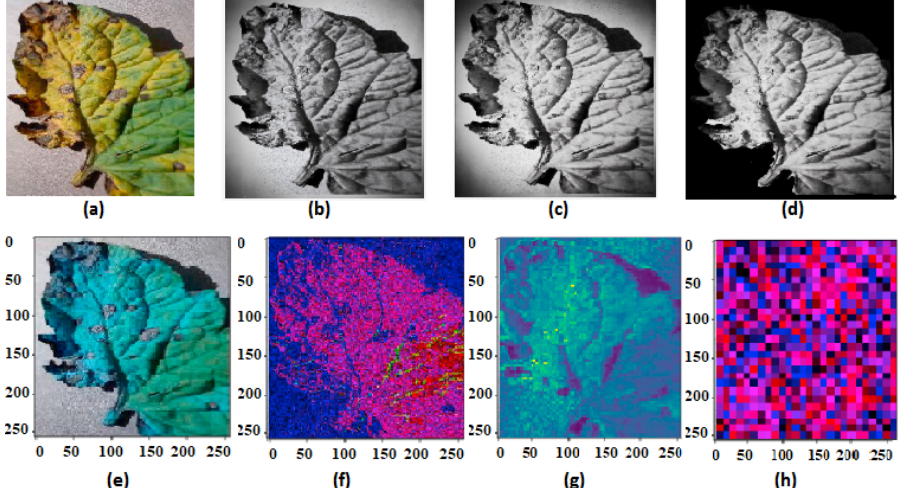
Figure 3. ( a ) Original image; ( b ) Gray scale image; ( c ) BF filtered image; ( d ) Otsu’s image segmented image; ( e ) extracted features at first dilated convolution layer; ( f ) extracted features at the second hid- den layer of dilated convolution; ( g ) extracted feature at the third hidden layer of dilated convolution; and ( h ) extracted features at attention